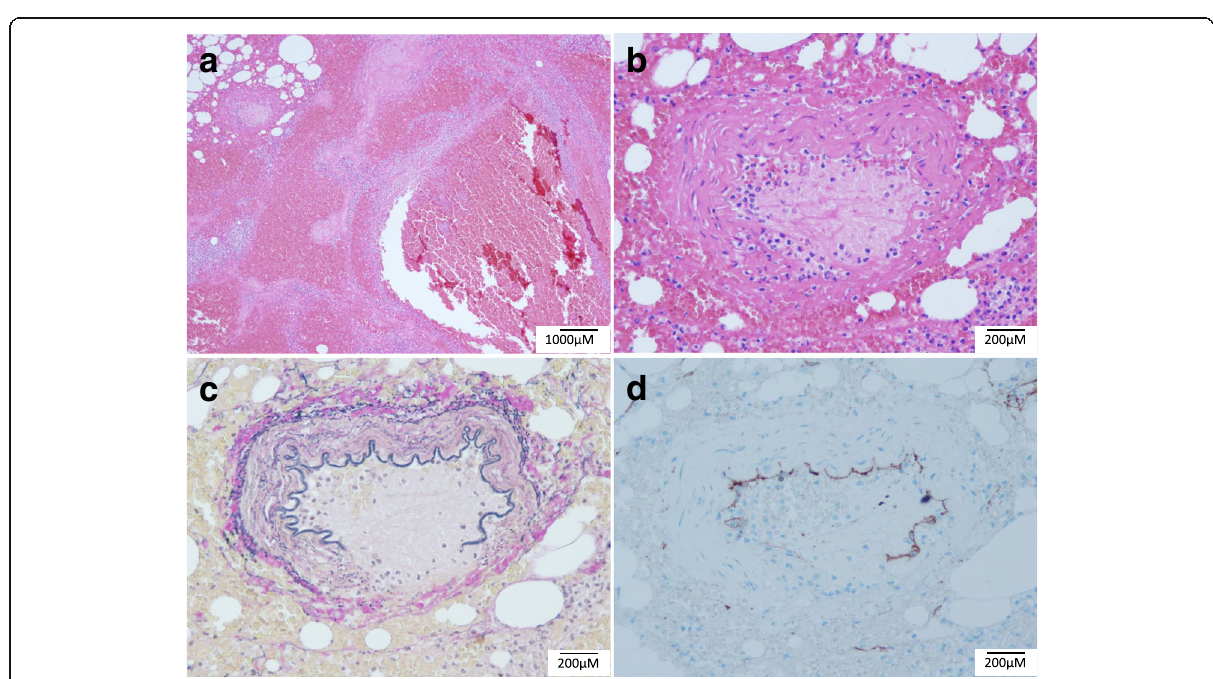
Fig. 3 Pathological findings of the resected specimen. Histological sample of the colon shows ulcerative lesions and fibrinoid necrosis ( a , hematoxylin and eosin [HE] staining, × 40). Fibrinoid necrosis and neutrophil infiltration of the small vessel ( b , HE staining, × 200) and loss of vascular wall ( c , Elastica van Gieson staining, × 200; d , cluster of differentiation 34 staining, × 200) are demonstrated